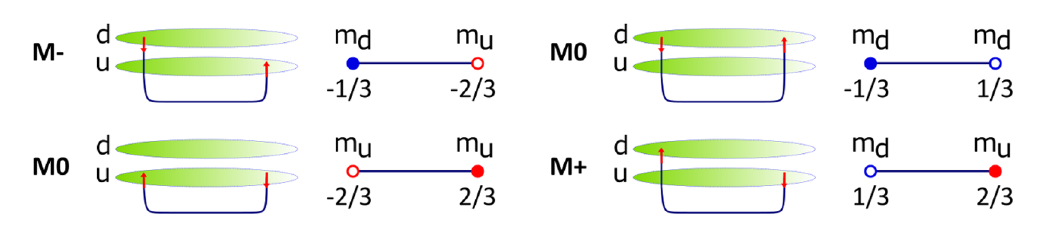
Figure 1 . The holographic stringy con(cid:12)gurations for mesons with charges (cid:0) 1 ; 0 ; +1 associated with the u and d (cid:13)avor branes (left) and the corresponding HISH mesons (right).